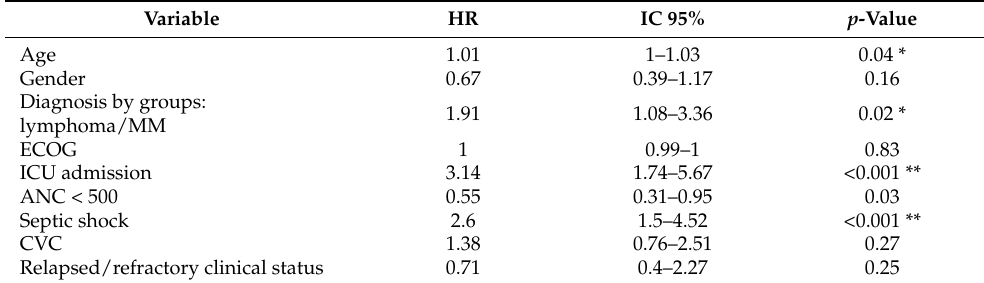
Table 4. Univariate analysis for overall mortality.